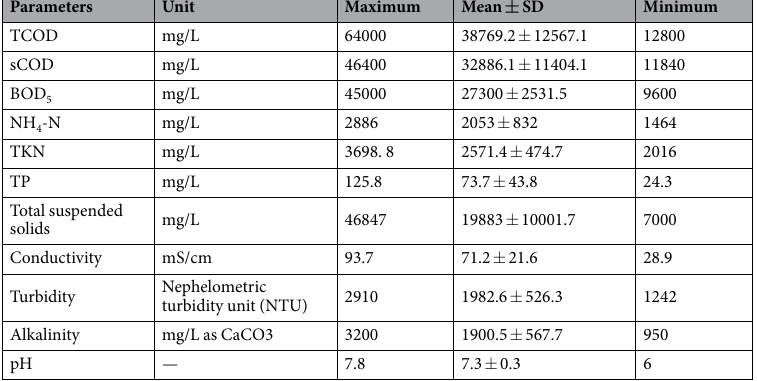
Table 2. Characteristics of MLL.